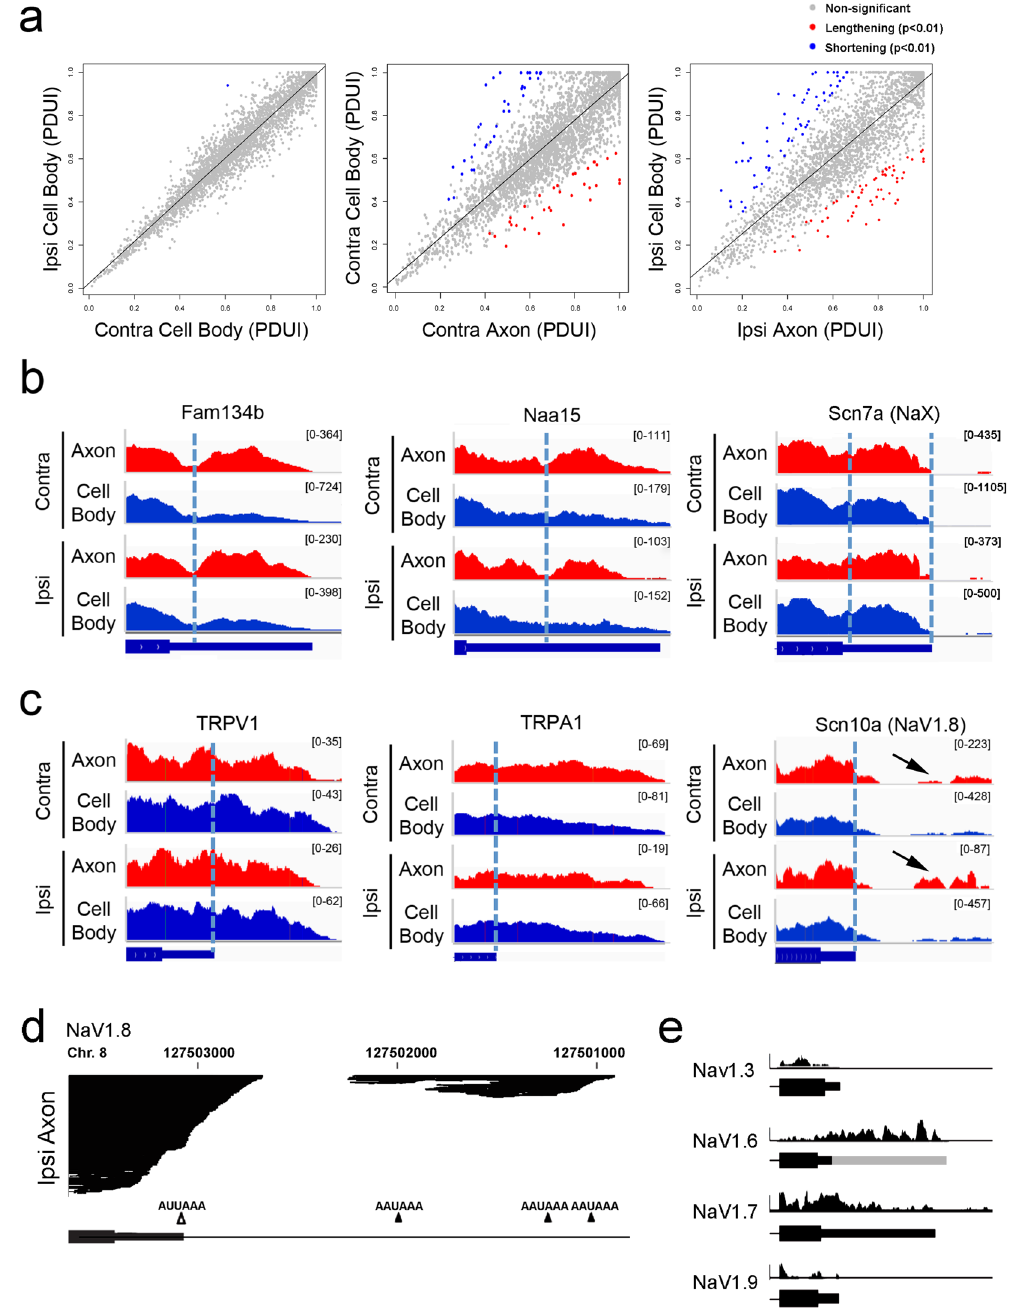
Figure 3. The 3 ′ UTR analysis was carried out by Dynamic analyses of Alternative Polyadenylation from RNA-Seq (DaPars) 51 . ( a ) The Differential Percentage of Distal PolyA site usage index (DPDUI) did not detect significant differences between RNA samples of ipsi and contralateral cell body groups. However, the axon samples showed either lengthening or shortening of 3 ′ UTRs as compared to the corresponding cell body samples at the adjusted significance level of p < 0.01. ( b ) DaPars identified alternatively extended 3 ′ UTRs in ipsi and contra axons of Fam134b, Naa15 and Scn7a (NaX) mRNAs. ( d ) DaPars further predicted “novel” differential 3 ′ UTR structures that were not identified in the rat genome sequence (Build rn5). TRPV1 and TRPA1 exhibited extended 3 ′ UTRs in cell body and axon groups. Scn10a encoding voltage-gated sodium channel 1.8 (NaV1.8) exhibited the possible presence of an alternative exon (arrows) distal to the annotated 3 ′ UTR predominantly in the ipsi axon samples. ( d ) RNA-Seq reads of Scn10 (NaV1.8) in the ipsi axon were found accumulated distal to the annotated 3 ′ UTR. The genomic DNA sequence suggested the presence of multiple polyA signal consensus sequences within the area of accumulated RNA-Seq reads. ( e ) NaV isotypes: NaV1.3, NaV1.7 and NaV1.9 did not show alternative 3 ′ UTR structures, whereas NaV1.6 exhibited the 3 ′ UTR extension in cell body and axon samples. The long 3 ′ UTR has not been reported in rats; however, human and mouse NaV1.6 were reported to have alternative 3 ′ UTR structures (gray